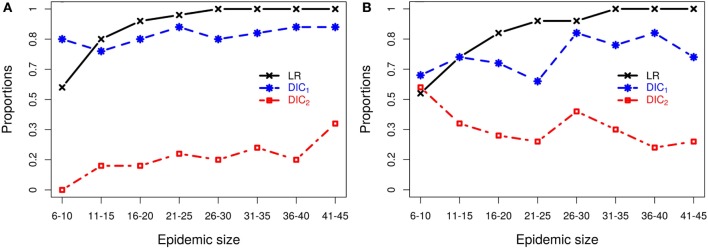
Probabilities of correctly selecting the right model using latent residuals (LR), DIC1, and DIC2 in the case of (A) simulation study 2a (using K1 to simulate the data) and (B) simulation study 2b (using K2 to simulate the data). Both graphs show that the LR perform better (higher probabilities) in selecting the right kernels than the DICs as the epidemic size increases.